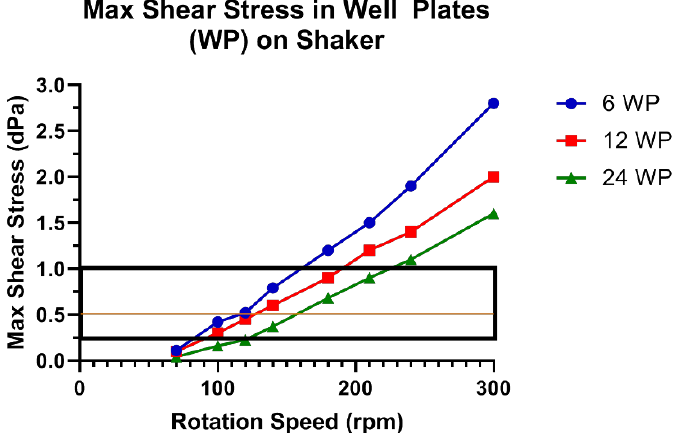
Figure 3. Maximum shear stress in 6, 12 and 24 WP at increasing rotation speeds. While all values are within physiological relevance, 0.25 and 1 decipascals (dPa) were chosen to achieve a low but appreciable value with 0.5 dPa as a rough goal.